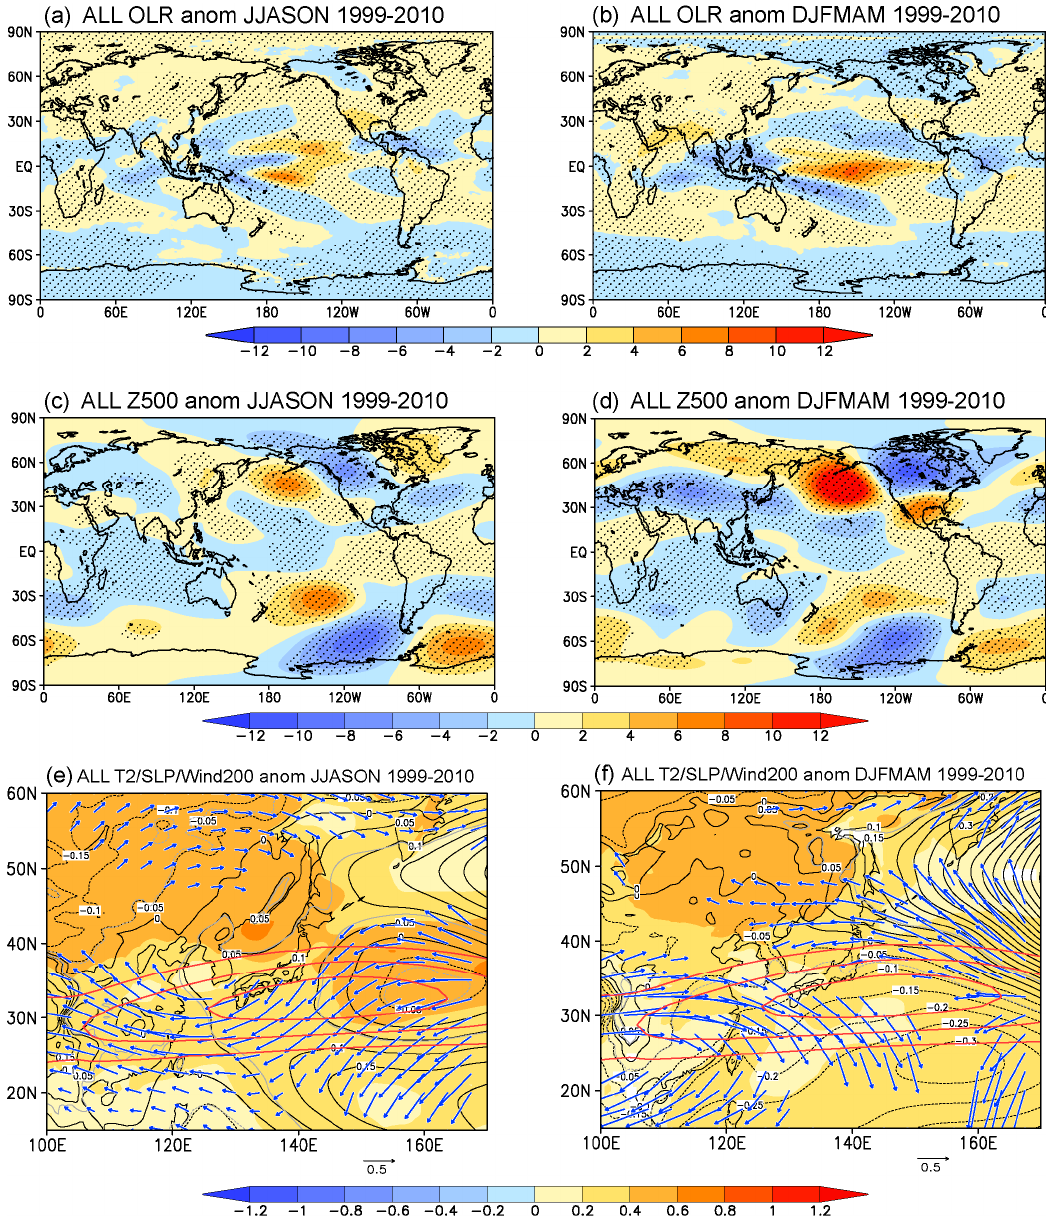
Figure 3. One hundred-member ensemble-mean anomalies of the all-forcing (ALL) run averaged from 1999 to 2010 for JJASON (left) and DJFMAM (right). ( a , b ) OLR (W/m 2 ), ( c , d ) Z500 (m, zonal mean is removed), ( e , f ) surface air temperature (shading, K), SLP (contours, hPa), and 200 hPa wind velocity (arrows, m/s). In ( a – d ), dotted areas show values exceeding the 99% confidence level. In ( e , f ), red contours show 50, 60, and 70 m/s of climatological westerly as a reference of a mean position of the Asian Jet, and gray contours show the 99% confidence level of SLP. Values exceeding the 99% confidence level are shown for surface air temperature and 200 hPa wind anomalies.